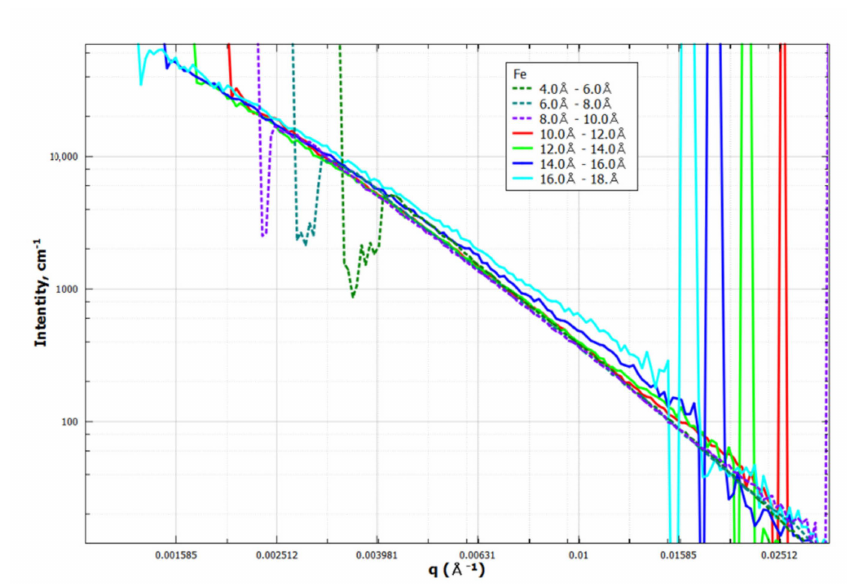
Figure A2. Typical example of contaminated neutron scattering